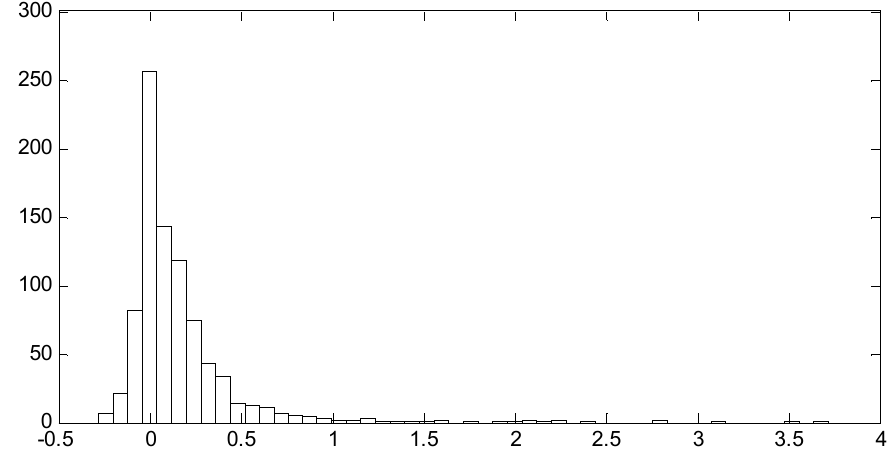
Figure 1. Histogram of the initial returns for the sample of 866 companies taken public between January 1999 and May 2010 on AMEX, NASDAQ, and NYSE exchanges.